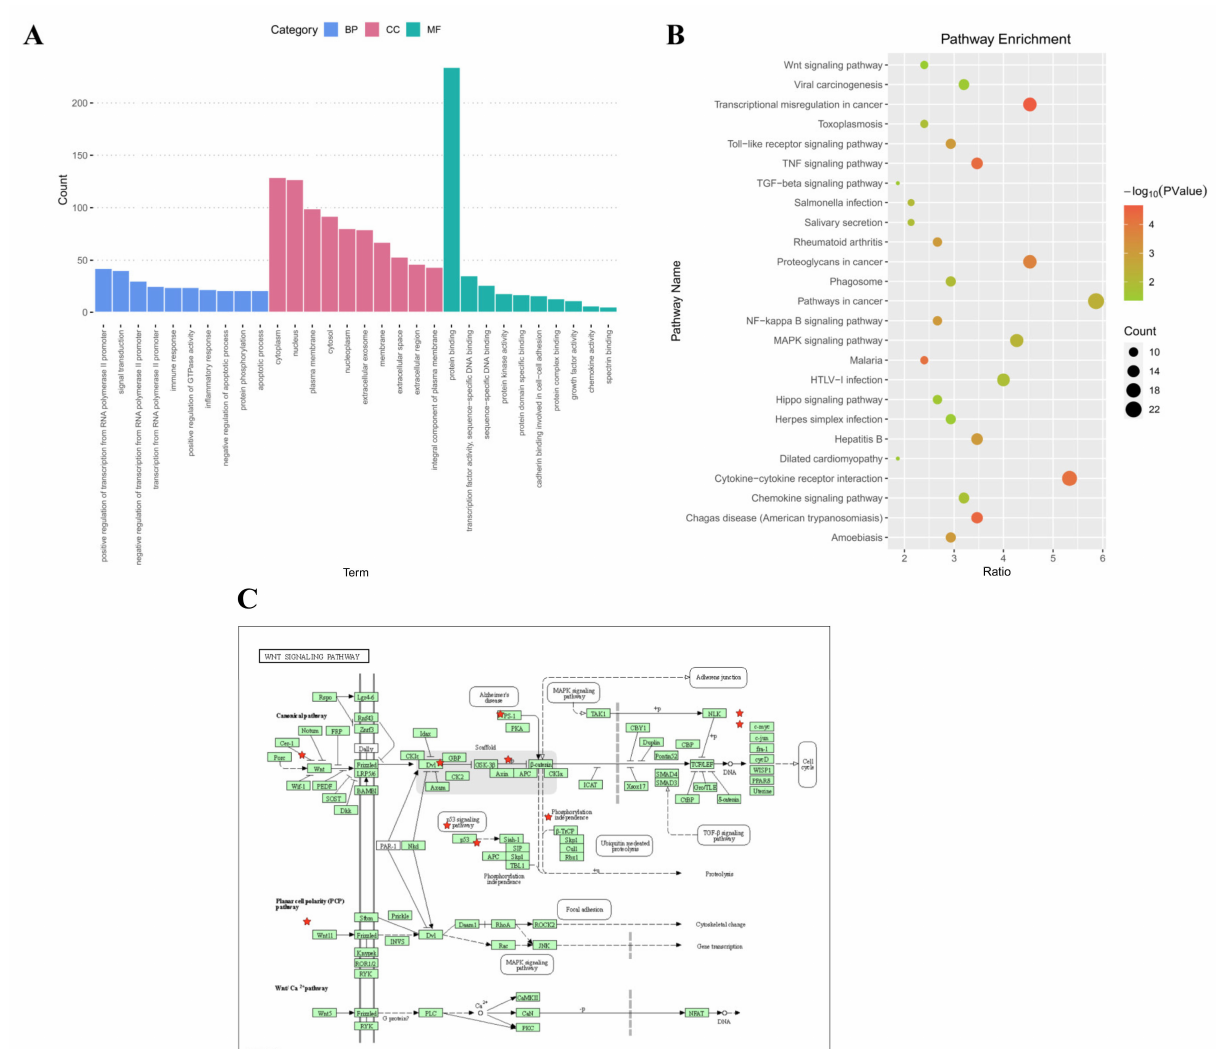
Figure 5. Bioinformatics analysis of lncSNHG7. ( A , B ) GO and KEGG pathway analysis of lncSNHG7. ( C ) Wnt signaling pathway map. Red Stars: The potential target gene of lncSNHG7 involved in Wnt signaling